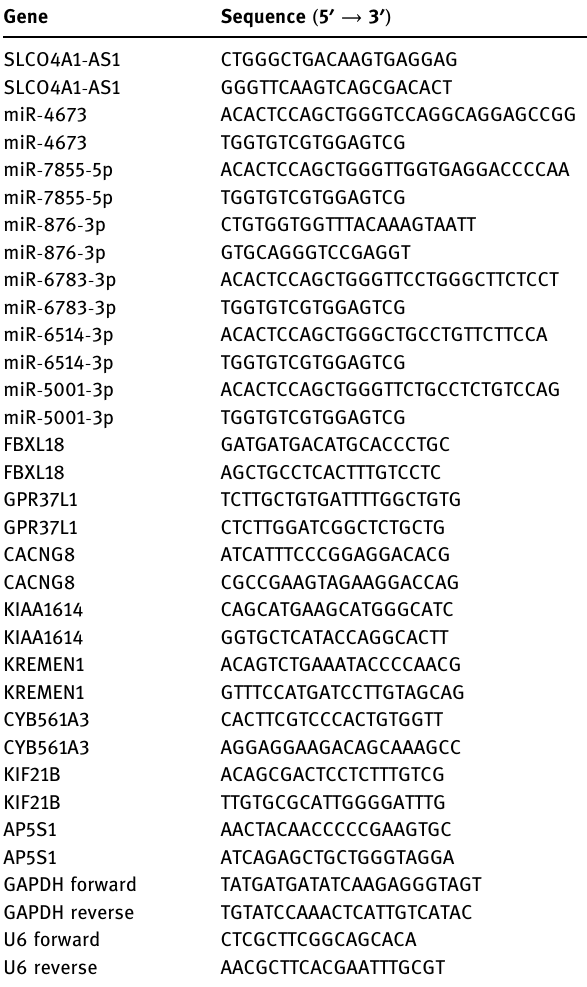
Table 1: Primer sequences used for qRT -